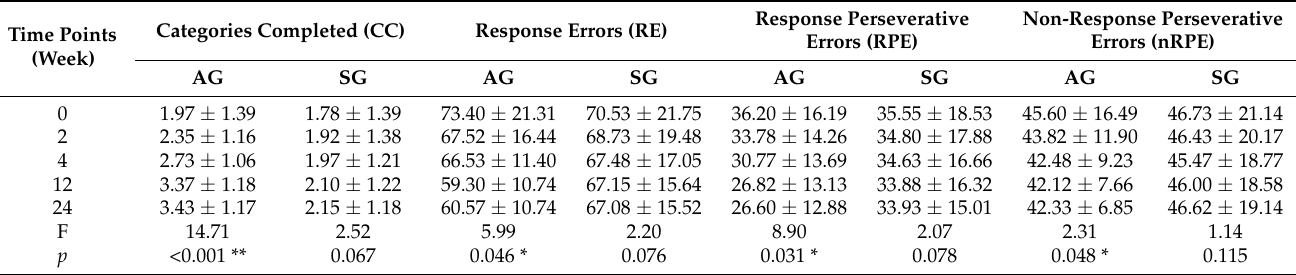
Table 4. Comparison of WCST scores between the two groups across the assessment time